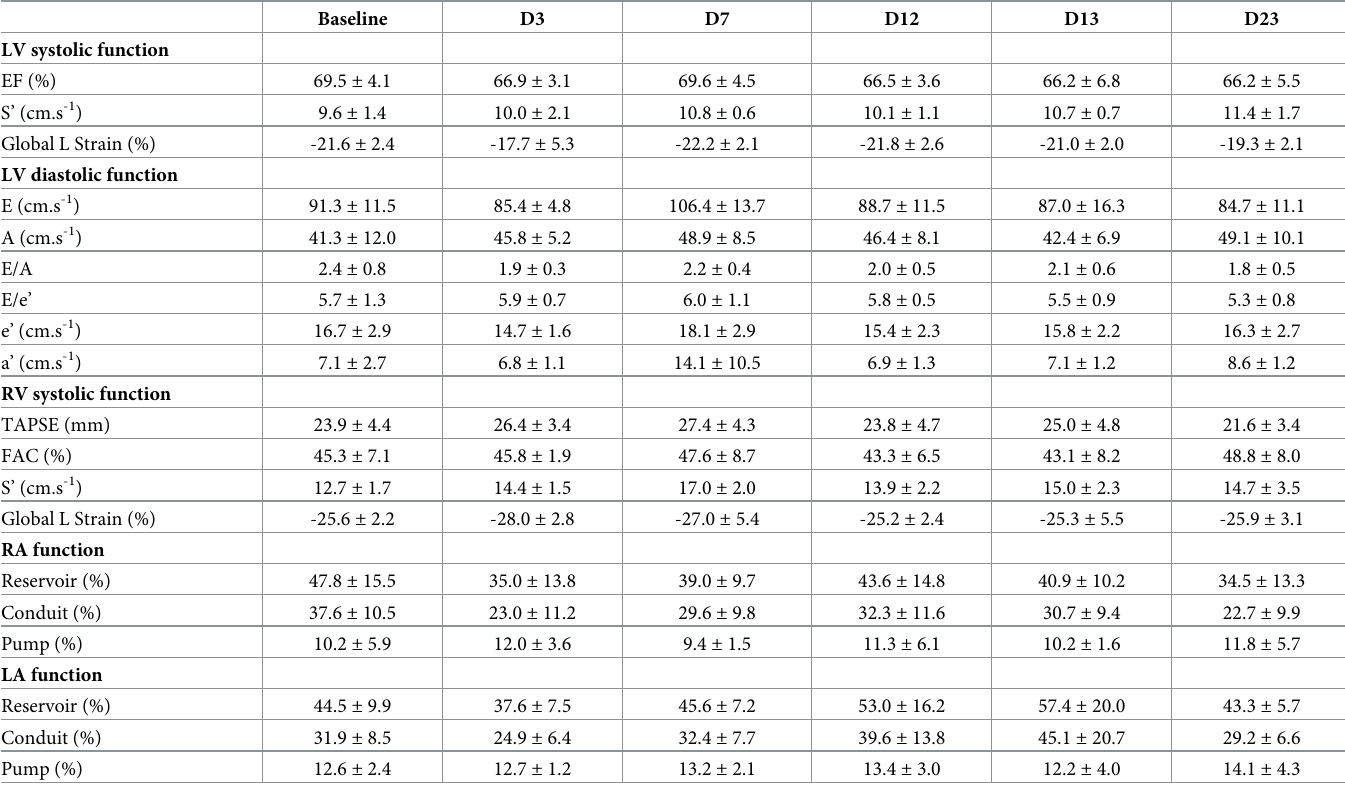
Table 5. Rest cardiac function parameters measured by